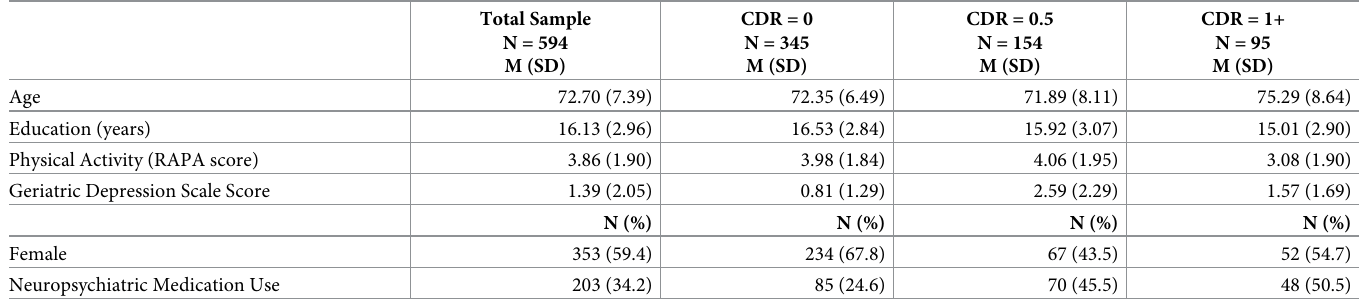
Table 1. Baseline participant